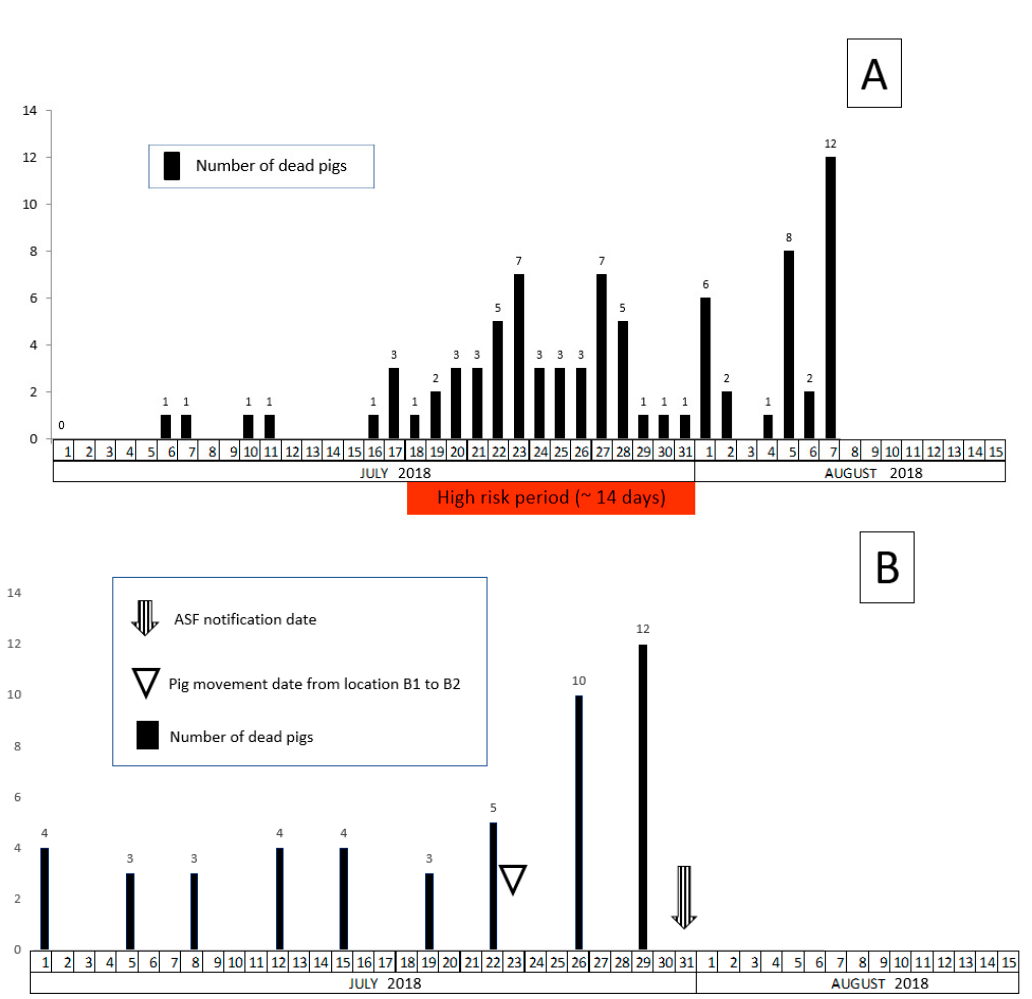
Figure 3. Timeline of the disease event in location B2 stable 4 ( A ) and B1 stable 4 ( B ) and the estimated high risk period for farm B.